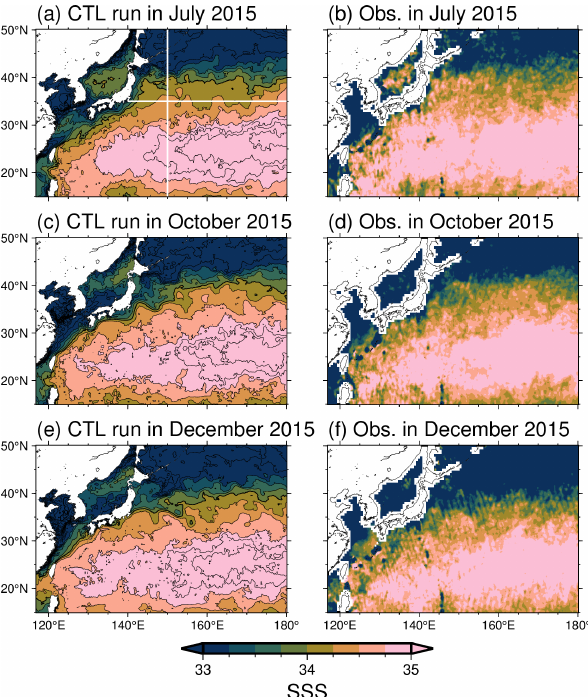
Figure 2. Same as Fig. 1 but for SSS. Thin (thick) black contour intervals are 0.25 (2). In panels (b) , (d) , and (f) , contour intervals are not shown because the satellite observations are